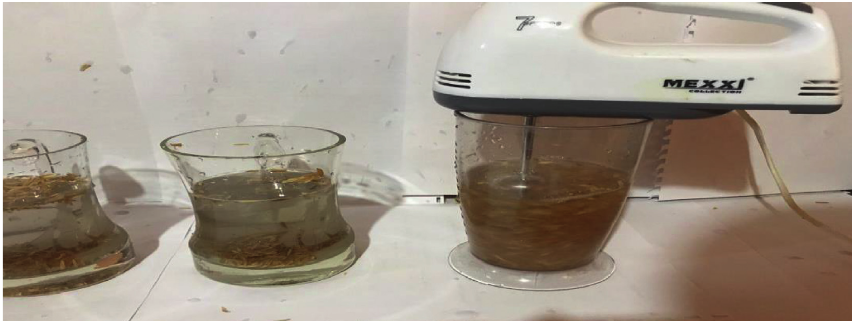
Figure 2: Adapted Jar test used in this study.